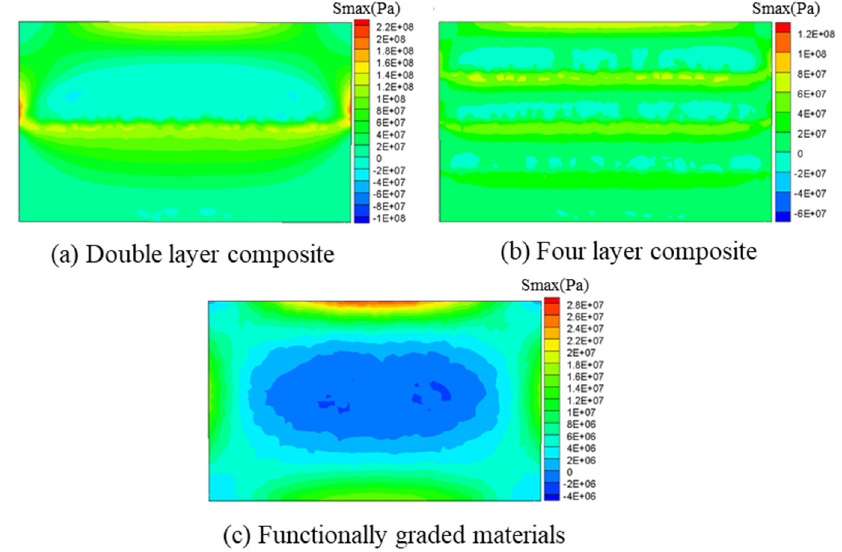
Figure 16. Residual maximum principal stress distribution in composite material and FGMs: ( a ) Double layer composite, ( b ) Four layer composite, ( c ) FGMs.